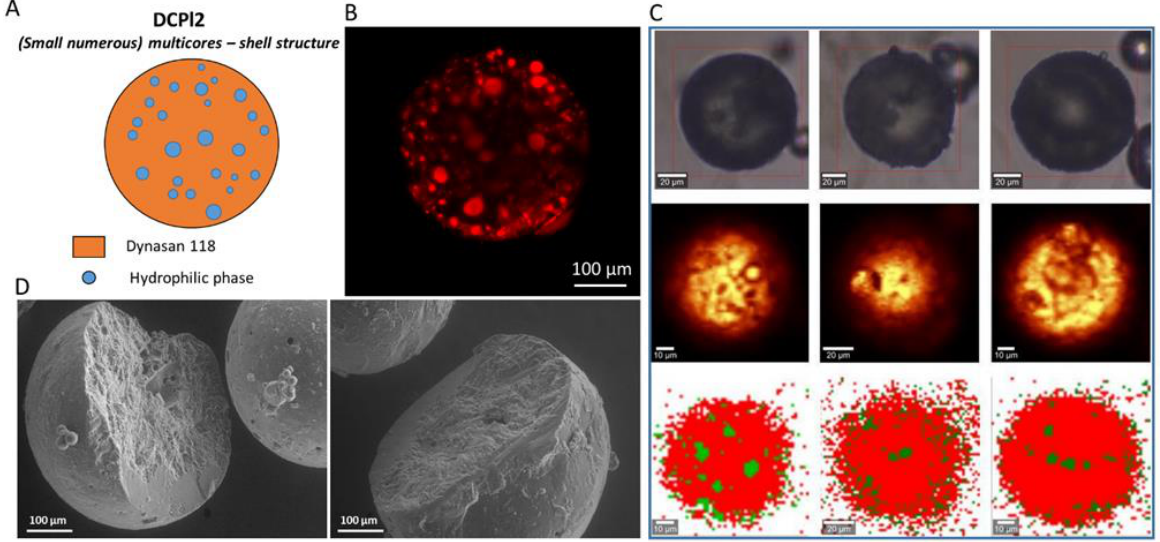
Figure 6. Internal morphology of DCPl2 b-MPs. Schematic illustration of particle structure ( A ). CLSM images, Rho (red color) solubilized in the hydrophilic phase was used as fluorescent probe ( B ). Raman mapping images. The first row (at the top) shows visible pictures; the second row shows Raman images obtained based on the integration of characteristic Raman bands at 2852 and 2886 cm − 1 ; the third row shows Raman images: lipophilic phase (red area) and hydrophilic phase (green area) ( C ). SEM images of cross-sections of DCPl2 b-MPs ( D ).